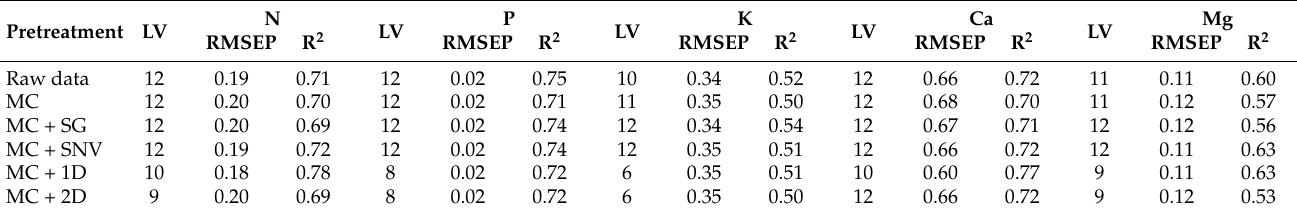
Table 3. Comparative statistics on reflectance for the test sets of the model generated by PLS-R for prediction of macronutrients (N, P, K, Ca and Mg). Mean center (MC), Savitzky-Golay (SG), Standard Normal Variate (SNV), First Derivative (1D) and Second Derivative (2D).